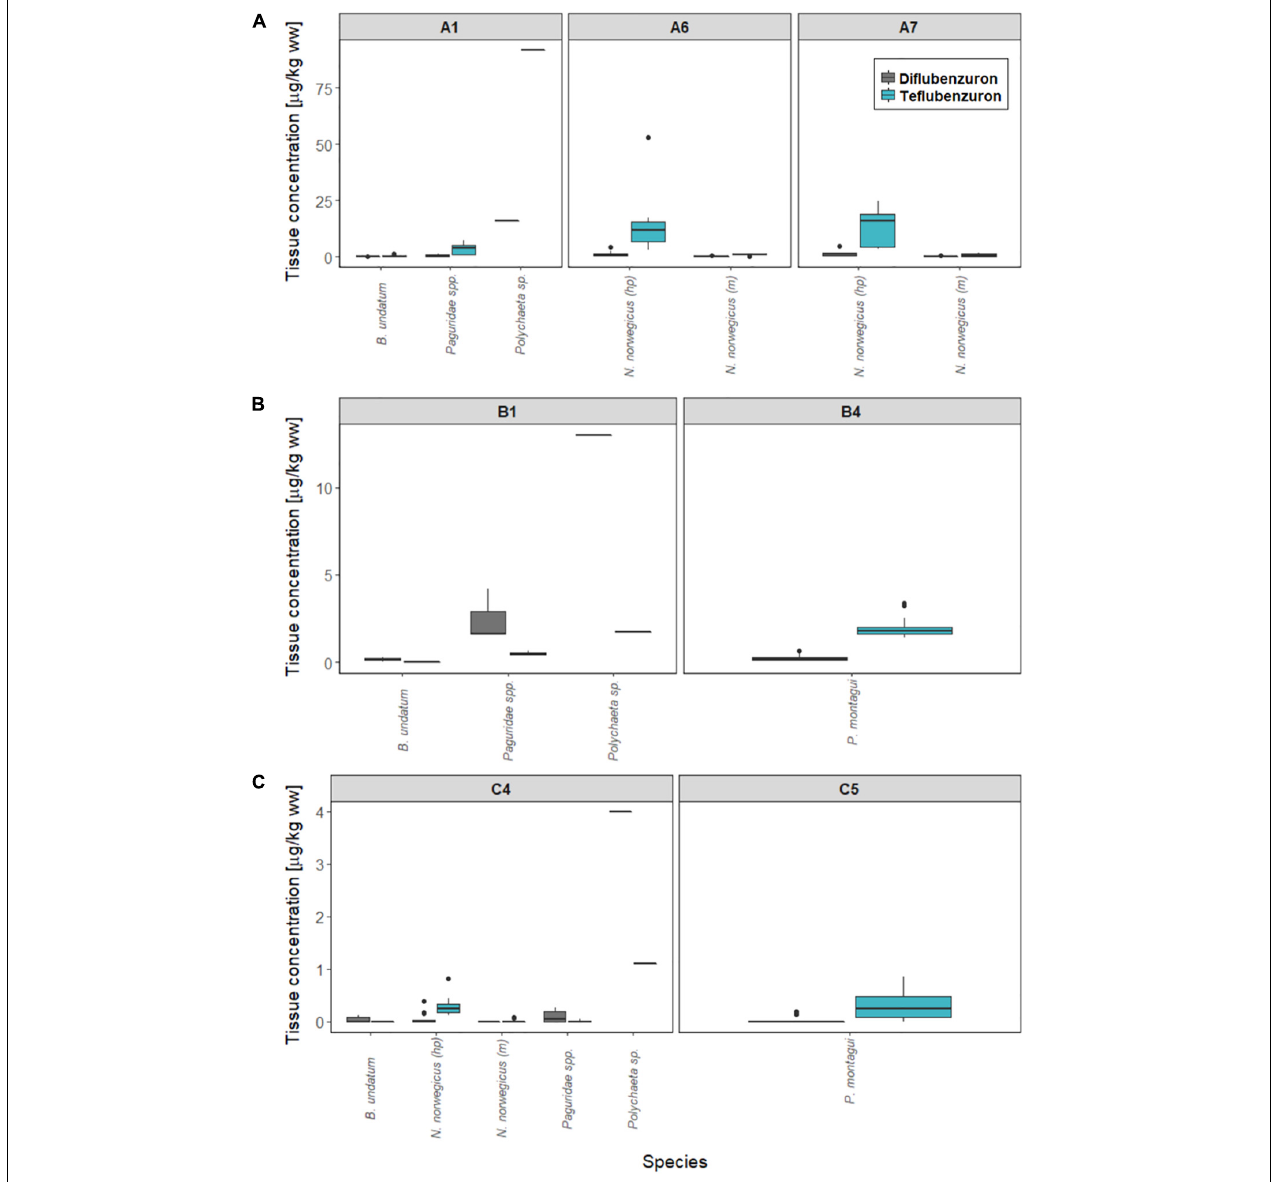
FIGURE 4 | Concentrations of anti-sea lice insecticides measured in marine biota sampled around Norwegian fish farms. Diflubenzuron (grey) and teflubenzuron (light blue) levels ( µ g/kg ww) are shown for each sampling station at (A) Farm A, (B) Farm B, and (C) Farm C. hp, hepatopancreas tissue; m, muscle